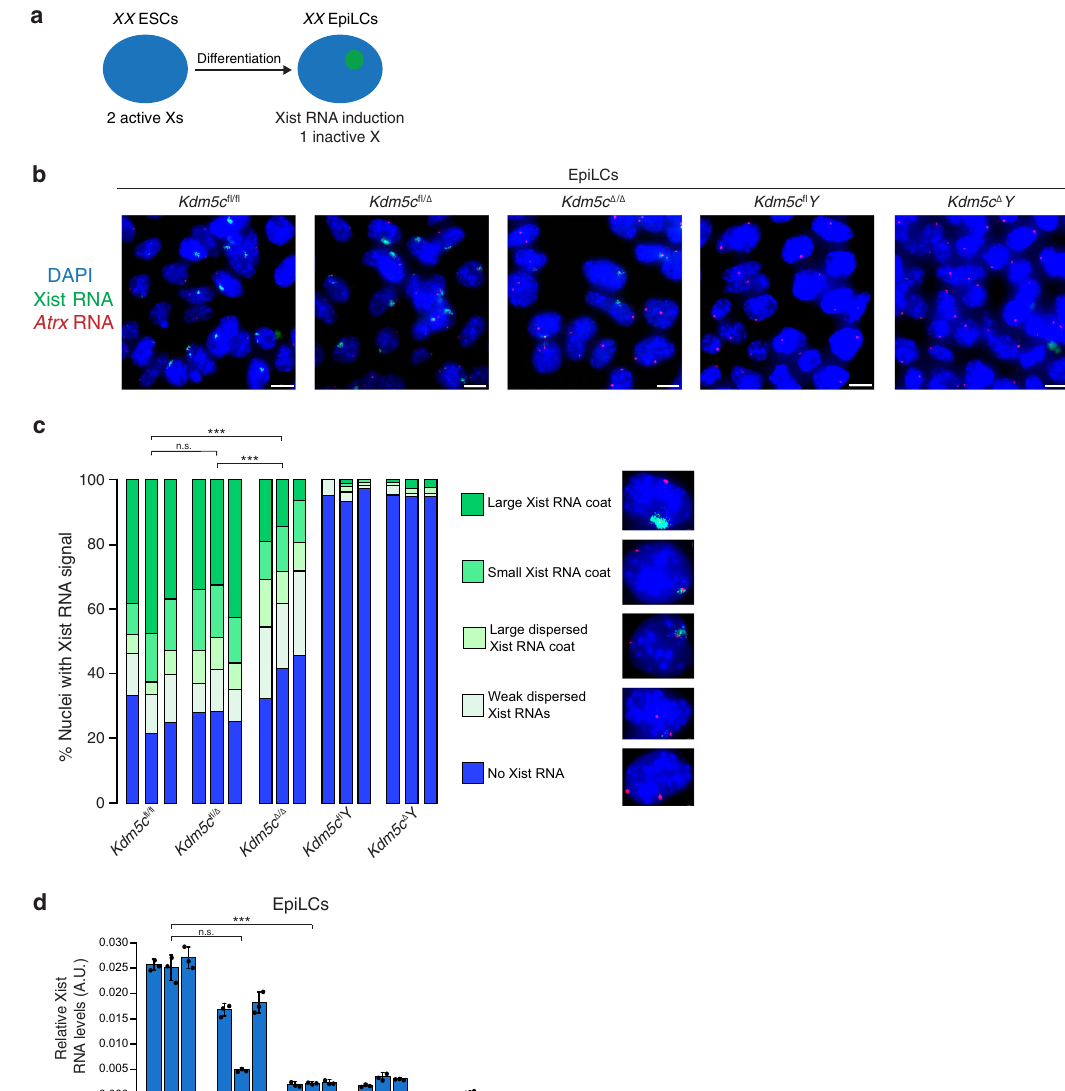
Fig. 3 Reduced Xist RNA expression in Kdm5c Δ / Δ female epiblast-like cells (EpiLCs). a Schematic of induction of X-inactivation upon differentiation of ESCs into EpiLCs. See also Supplementary Fig. 2a. b Detection of Xist RNA (green) by strand-speci fi c FISH together with Atrx RNA (red) in representative EpiLCs. Scale bars, 10 μ m. Three independent ESC lines were differentiated into EpiLCs/genotype with similar results. c Quanti fi cation of Xist RNA coating in EpiLCs. Xist RNA expression was quanti fi ed in fi ve categories. Numbers of nuclei counted in EpiLCs differentiated from each of three independent ESC lines/genotype: Kdm5c fl / fl , n = 154, 122, and 113; Kdm5c fl / Δ , n = 107, 140, and 130; Kdm5c Δ / Δ , n = 145, 163, and 151; Kdm5c fl Y , n = 124, 230, and 111; Kdm5c Δ Y , n = 110, 138, and 114. P values, Chi-square analysis between female genotypes. n.s. not signi fi cant; * P ≤ 0.05; ** P < 0.01; *** P < 0.001. See Supplementary Table 3 for Welch ’ s two-sided t test on all pairwise statistical comparisons. d Quanti fi cation of relative Xist RNA levels by RT-qPCR in the EpiLCs. Three independent ESC lines were differentiated into EpiLCs/genotype. Each bar in graph represents an individual ESC line differentiated into EpiLCs for each genotype. Data are presented as mean ± standard deviation between technical PCR replicates. P values, Welch ’ s two-sided t test on Δ Ct values of biological replicates. n.s. not signi fi cant; * P ≤ 0.05; ** P < 0.01; *** P < 0.001. See Supplementary Table 4 for all pairwise statistical comparisons. See also Supplementary Fig. 2b. Source data are provided as a Source Data fi